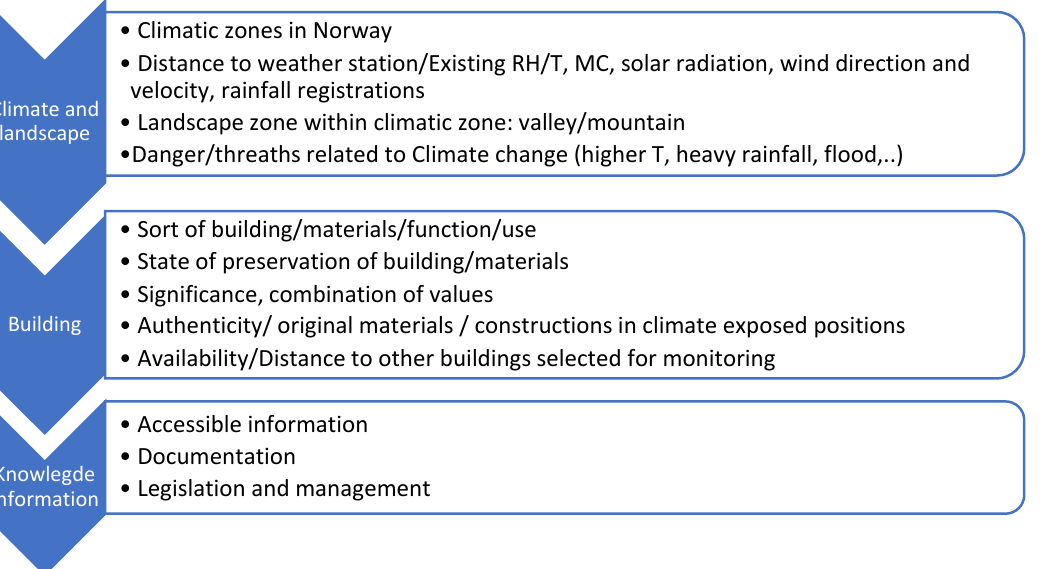
Figure 5. Garmo Stave Church, Lillehammer. Photo: NIKU.